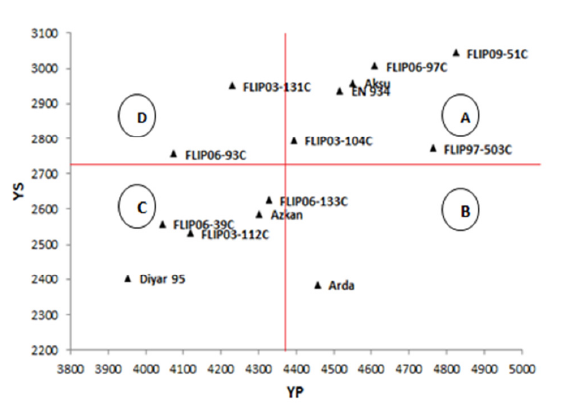
Fig. 1. The relationship between seed yield produced under no- stress and drought stress